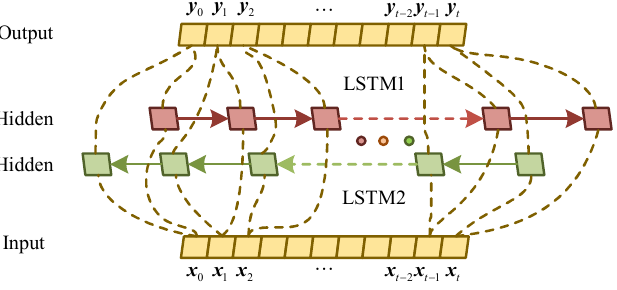
Figure 4. The structure of the LSTM model.